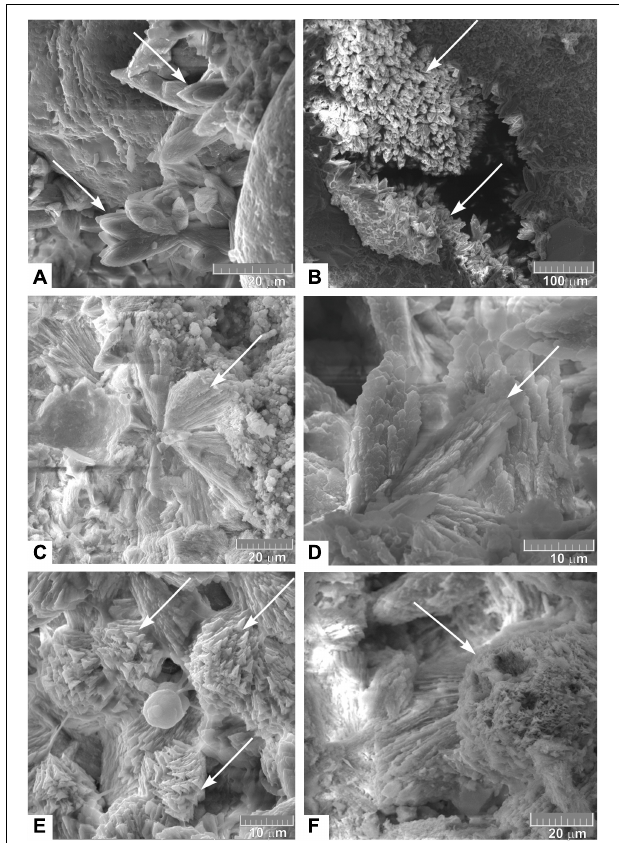
FIGURE 6 | Scanning electron micrographs of the clearly crystalline type of high-Mg calcite of the OD-I-1 carbonate crust: (A,B) scalenohedral crystals; (C,D) fan like crystals; (E,F) rhombohedral crystals and spherical formation of Mn hydroxide (todorokite) in the center of (E) . Arrows indicate different types of